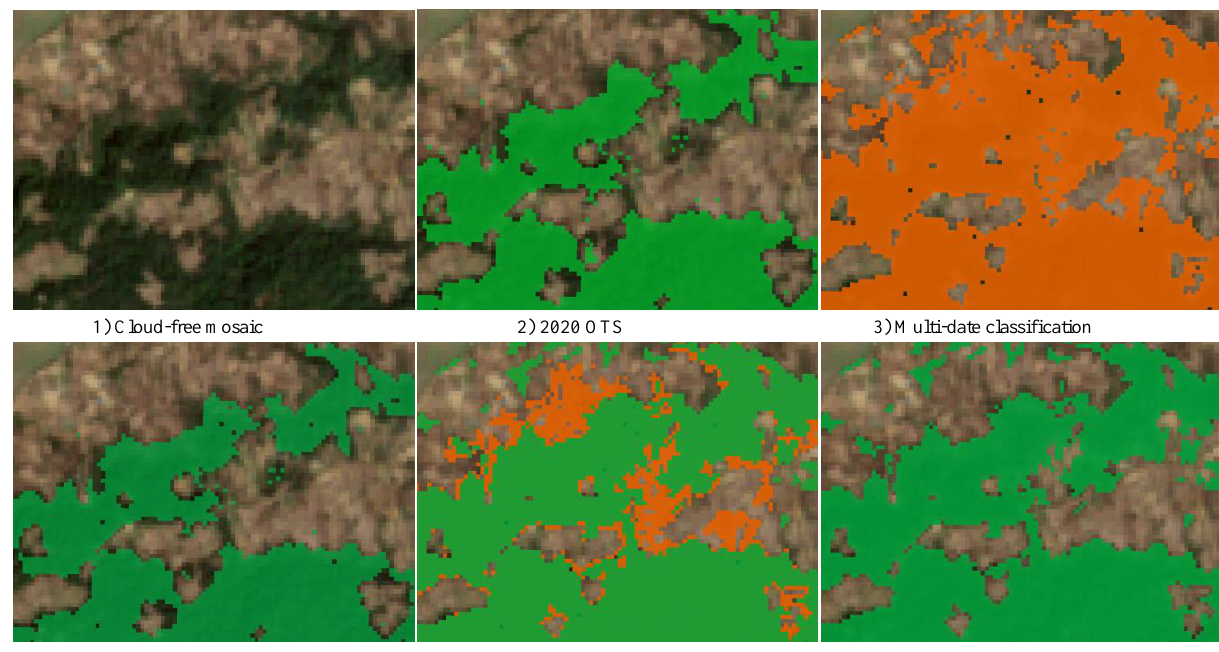
Figure 6: Results of the colour propagation